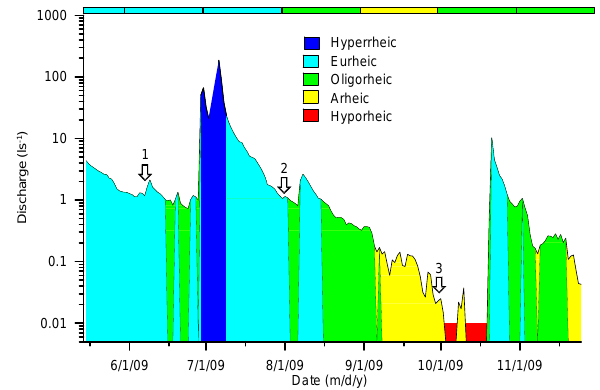
Fig. 3. Flow duration curve for the Vallcebre stream at Can Vila station, with identification of the minimum discharge thresholds that separate the diverse aquatic states.